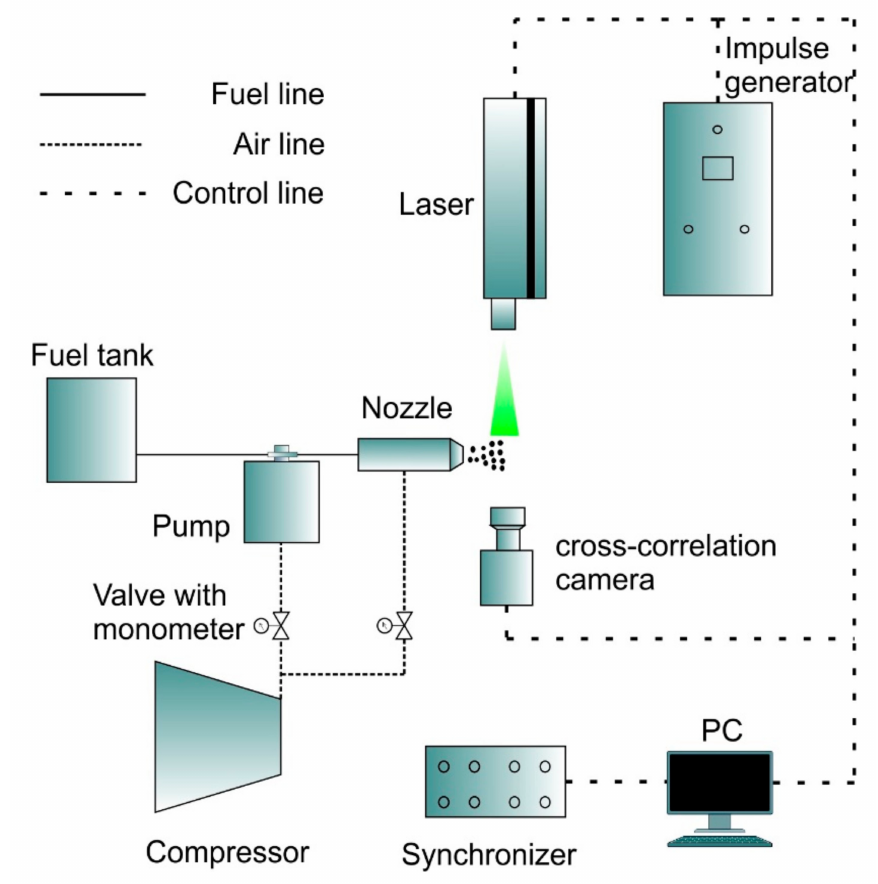
Figure 3. Schematic diagram of the experimental setup for liquid fuel spray